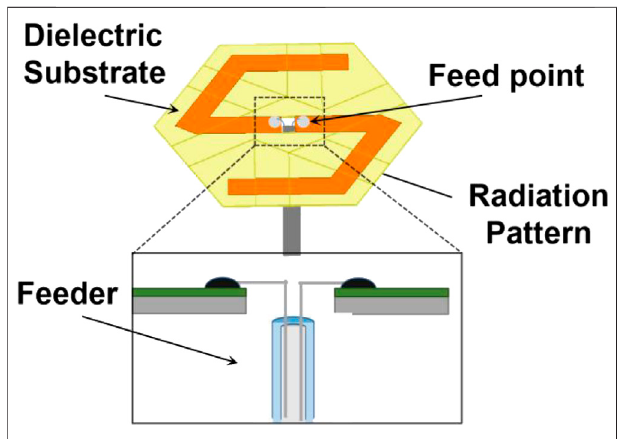
FIGURE 3 | The components of a hexagon-twist origami